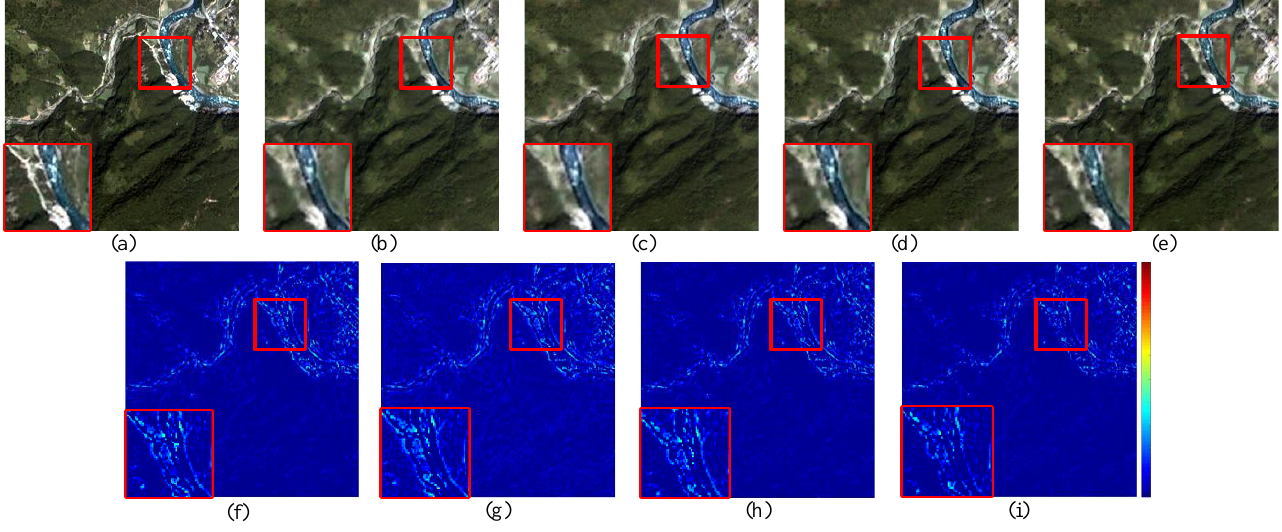
Figure 7. The comparison of the results for different structures. ( a ) The ground truth. ( b ) U-net. ( c ) U-net + AG: U-net with AG on the skip connections. ( d ) U-net + scale: U-Net with multi-scale cost function. ( e ) MSAC-Net. ( f – i ) are the spectral distortion maps corresponding to ( b – e